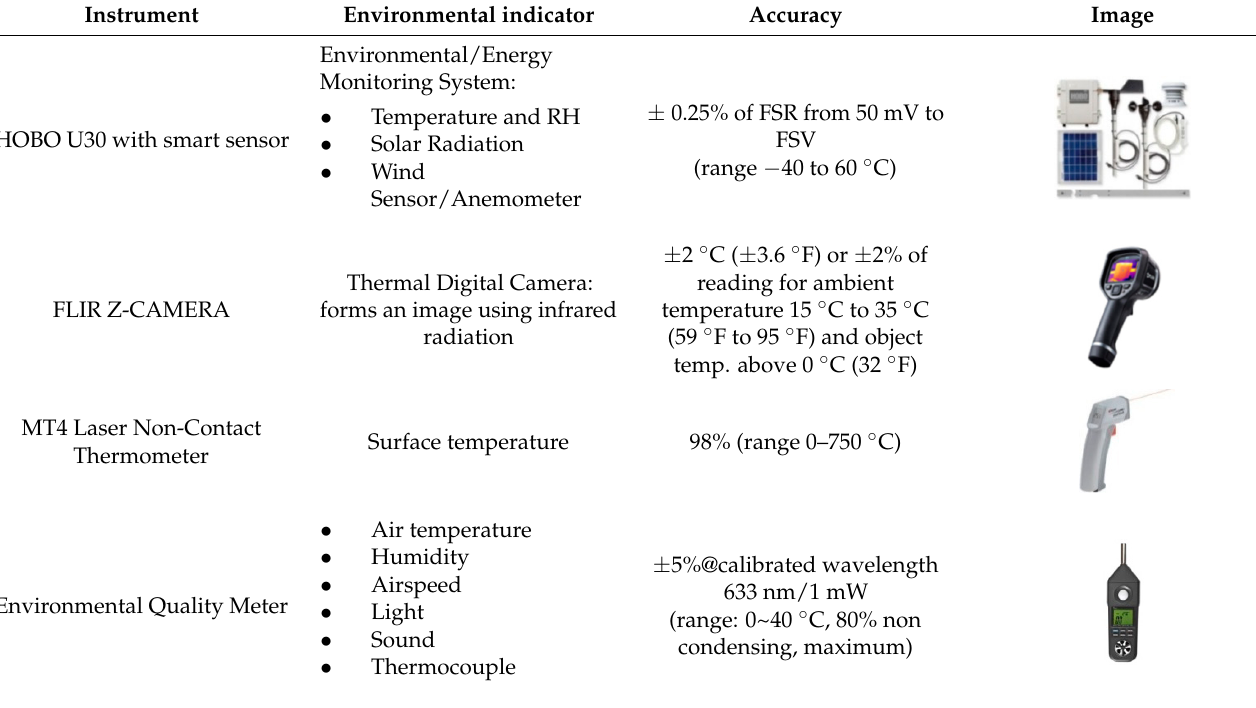
Table 4. Instruments used and their properties.